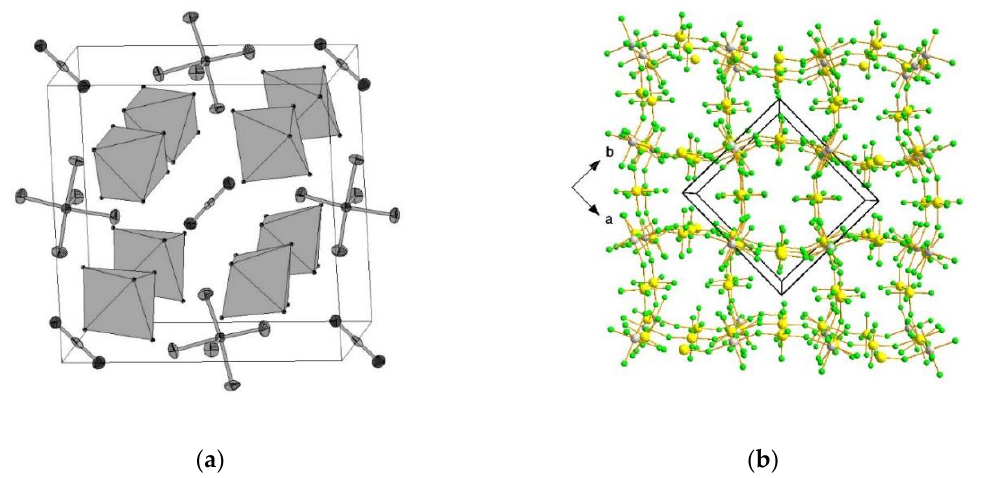
Figure 13. ( a ) Packing of [NO 2 ] + and [XeF 5 ] + cations, and [SbF 6 ] − anions in the crystal structure of NO 2 XeF 5 (SbF 6 ) 2 ; Only one of the two orientations of the disordered [SbF 6 ] − anions is depicted. Copyright (2015) Wiley. Used with permission from Ref. [39]; ( b ) The tri-dimensional [M(SbF 6 ) 3 ] − framework with the monoclinic unit cell in the crystal structure of α -XeF 5 M(SbF 6 ) 3 (150 K; M = Mn) isotypic to M 2 + = Mg, Co, Ni, Zn, and Cu compounds. The [XeF 5 ] + cations located within the cavities are omitted for clarity. Copyright (2016) Wiley. Used with permission from Ref. [40].